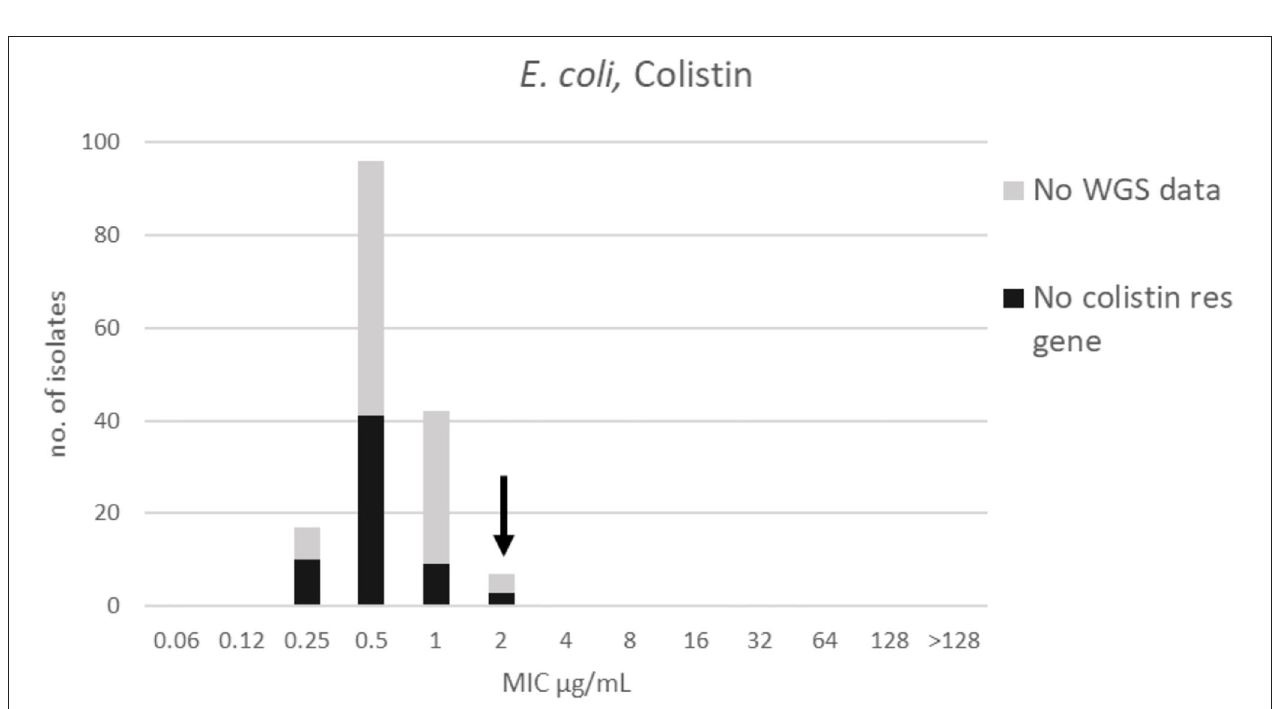
FIGURE 2 | MIC distribution for E. coli ( n = 162) against colistin in the test range 0.06–128 µ g/mL. The arrow indicates the epidemiological cut-off value (ECOFF, EUCAST). Colors indicate if the isolates have been sequenced and whether they habor known relevant resistance genes. WGS, whole-genome sequencing; res, resistance.